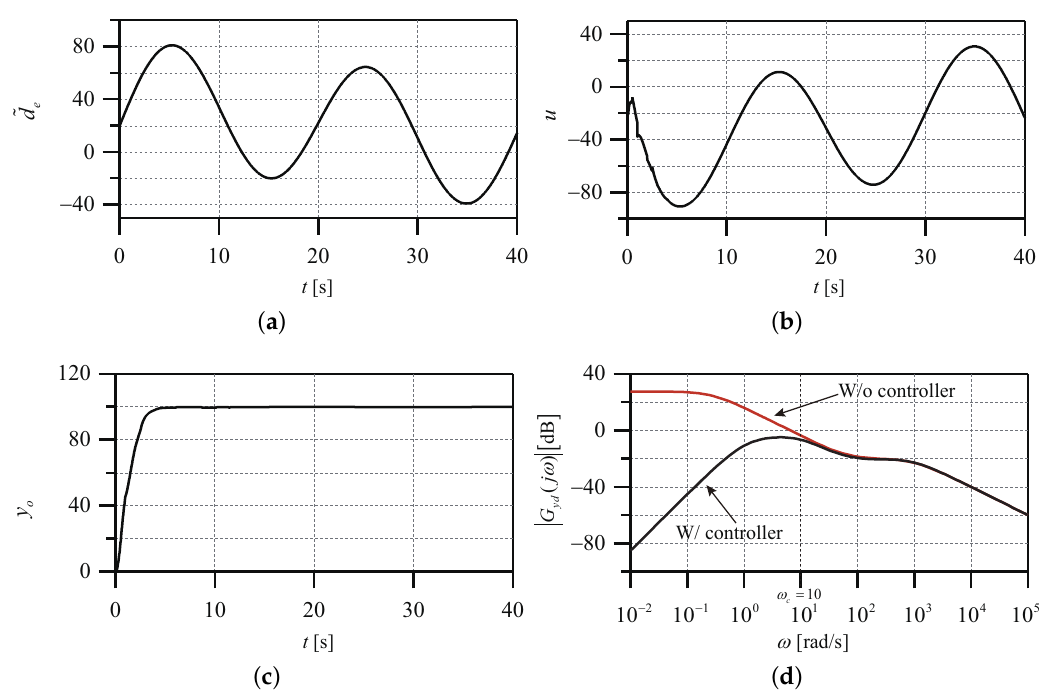
Figure 4. Simulation results for IEID-based NCS. ( a ) Estimated EID; ( b ) Control input; ( c ) System output; ( d ) Bode diagram from the exogenous disturbance and packet losses to the output.